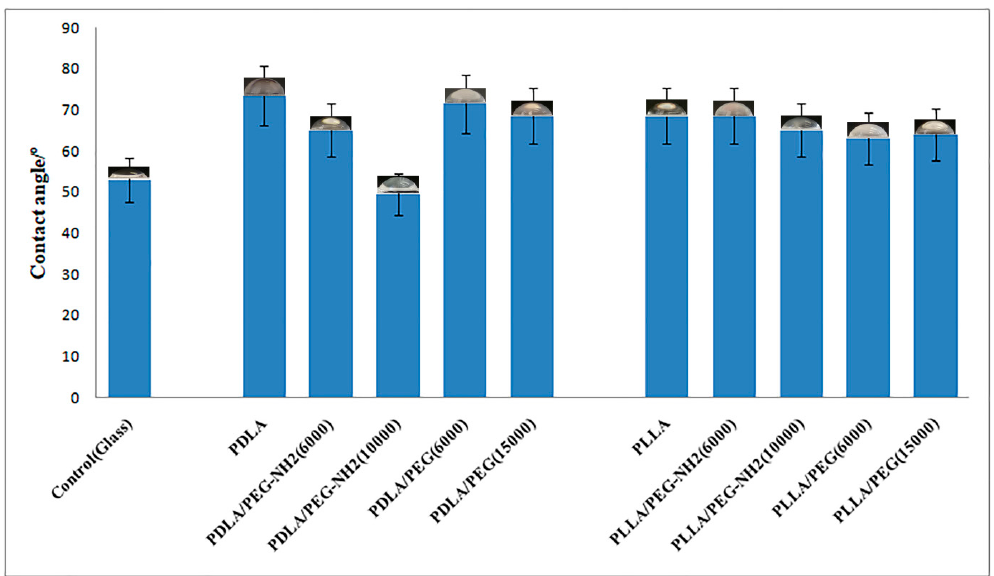
Figure 3. Contact angles of the pure PLA with different isomeric forms—PDLA and PLLA; the blend PLA/PEG or PLA/PEG-NH2 with different molecular weights of PEG (6000 or 15,000 g/mol) and PEG-NH2 (6000 or 10,000 g/mol).